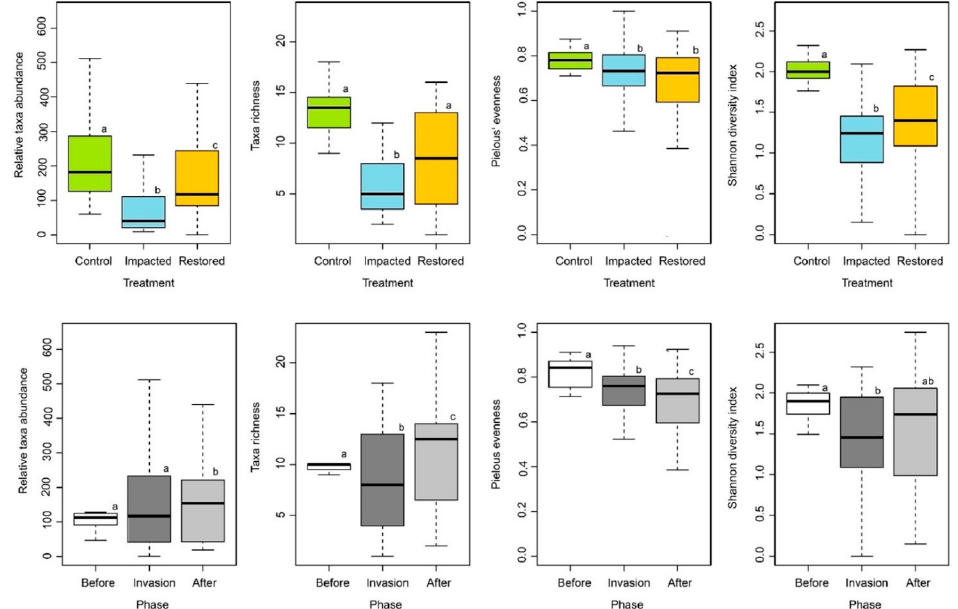
Figure 3. Aquatic macroinvertebrate biodiversity indices between treatments and phases. Box plots represent median values with interquartile range. Whiskers represent maximum and minimum values. Di ff erent lowercase letters represent significant di ff erences and like letters not significantly di ff erent. Control—open water; impacted—100% Salvinia molesta; restored— Salvinia molesta and Cyrtobagous salviniae treatments; before—“before” invasion phase; invasion—“during” invasion phase; after—“after” biological control phase. Aquatic macroinvertebrate biodiversity indices data (mean and standard deviation) per week are presented in Figure